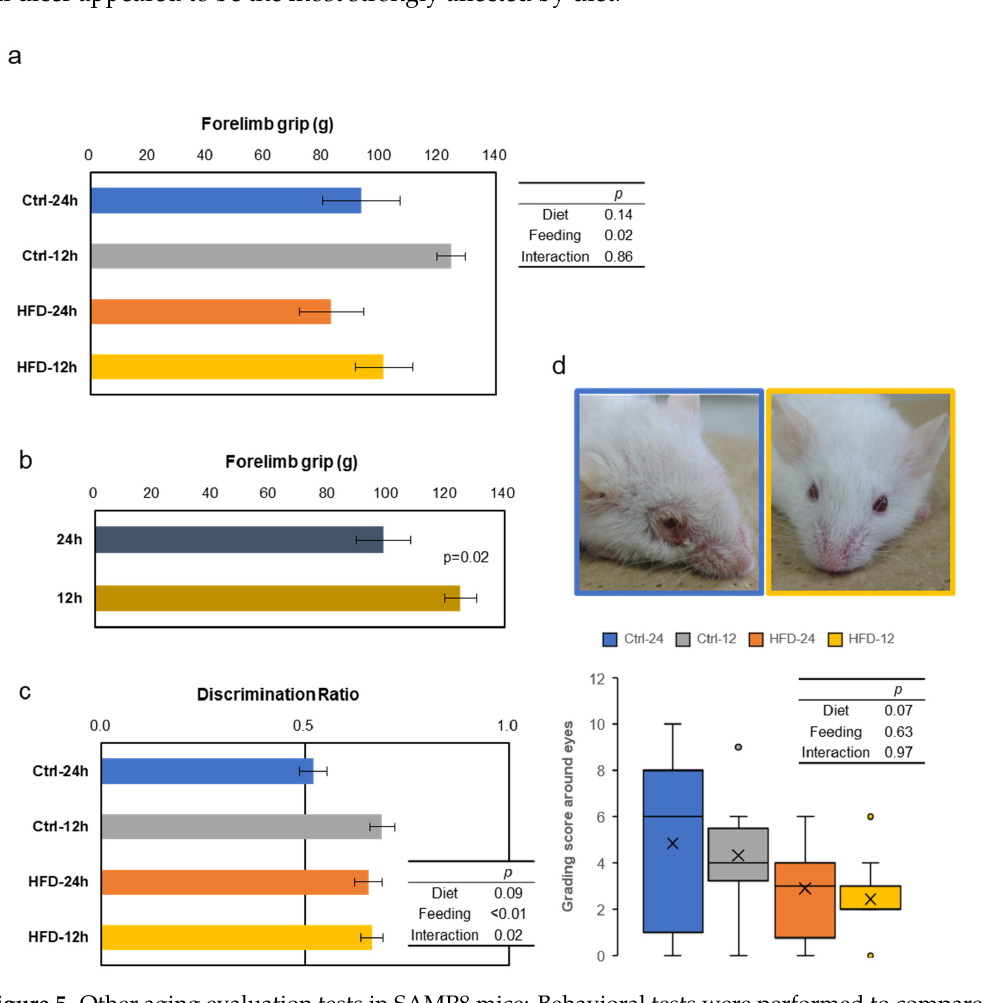
Figure 5. Other aging evaluation tests in SAMP8 mice: Behavioral tests were performed to compare effects of the diet and feeding on physical and mental performance with age. Results of grip strength ( a and b ), short memory by Novel Object Recognition Test (NORT) ( c ), and grading score about eyes with representative photos of the mice ( d ) at 15 m-old are shown ( N = 6–7 in each group). The mouse on the left panel shows 10 points from the Ctrl-24 h group, and the mouse on the right panel shows 0 points from the HFD-12 h group. The statistical p -values of two-way ANOVA are shown in the right table ( a , c and d ), and the p -values by comparing one condition with t-test is shown in the figure (b, N = 12